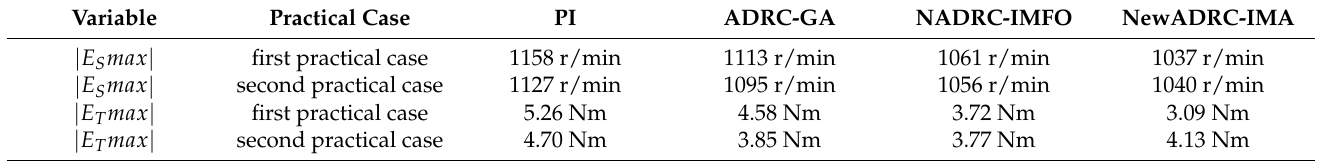
Table 2. The maximum absolute value of speed and torque error for each practical case.